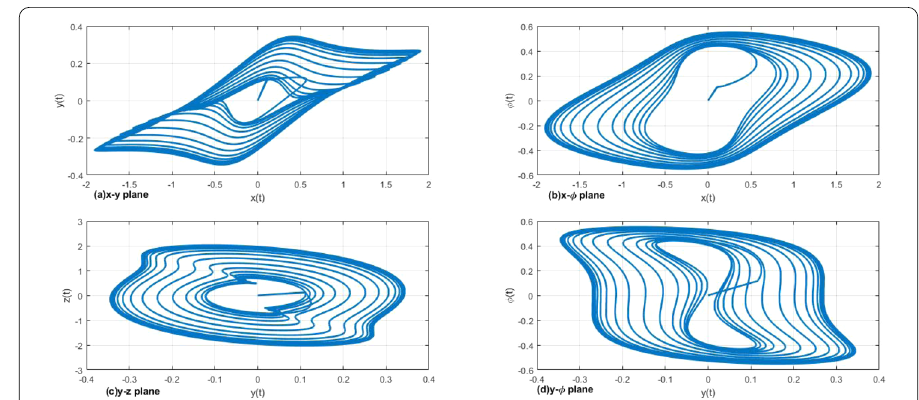
Figure 2 Phase portrait of model (21) for q = 0.95 projected on different planes